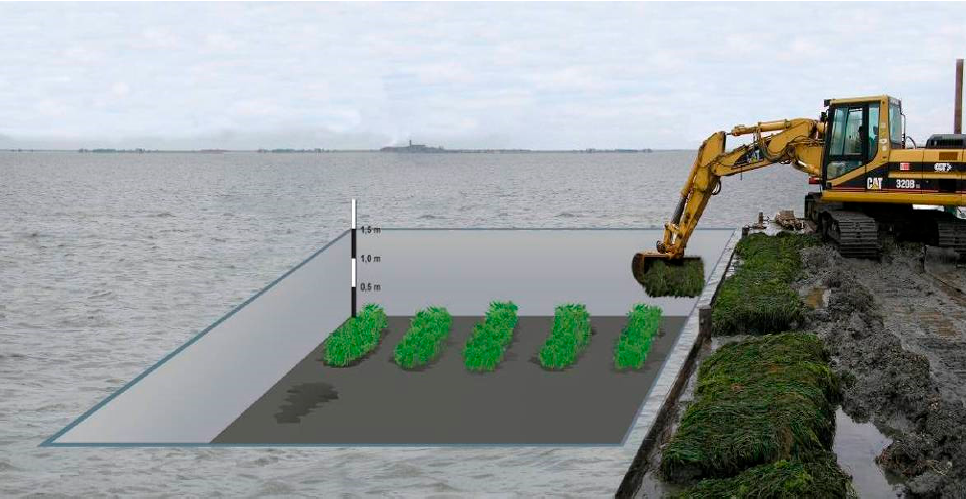
Figure 5. Representative diagram of the sods transplantation by power assisted means, pontoon and servo-assisted arm.